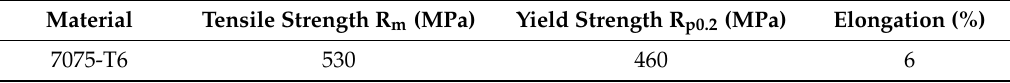
Table 2. Mechanical properties of